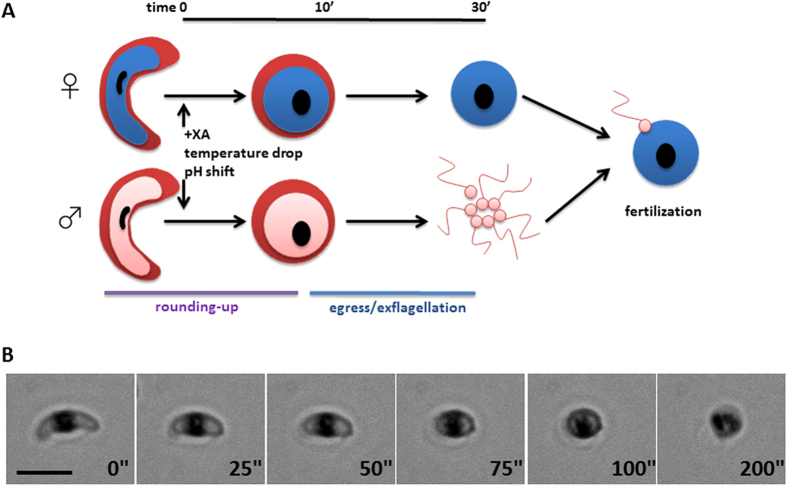
(A) The mature gametocyte activation process (modified from44). (B) Time lapse of gametocyte rounding-up.